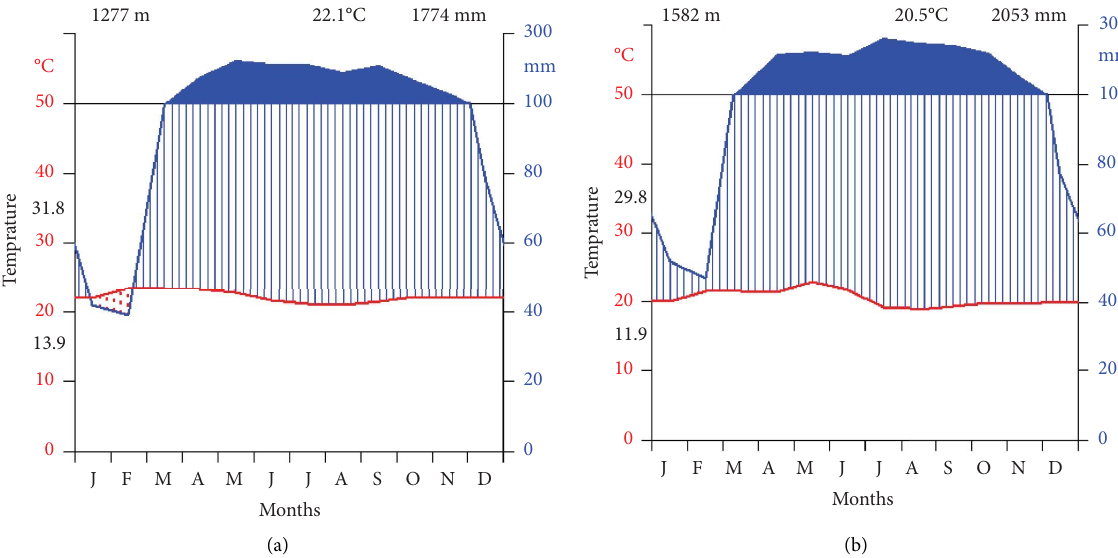
Figure 2: Mean monthly temperature and rainfall recorded. (a) Tinishu Meti (1987–2017) and (b) Ermichi (1987–2017) (NMSA